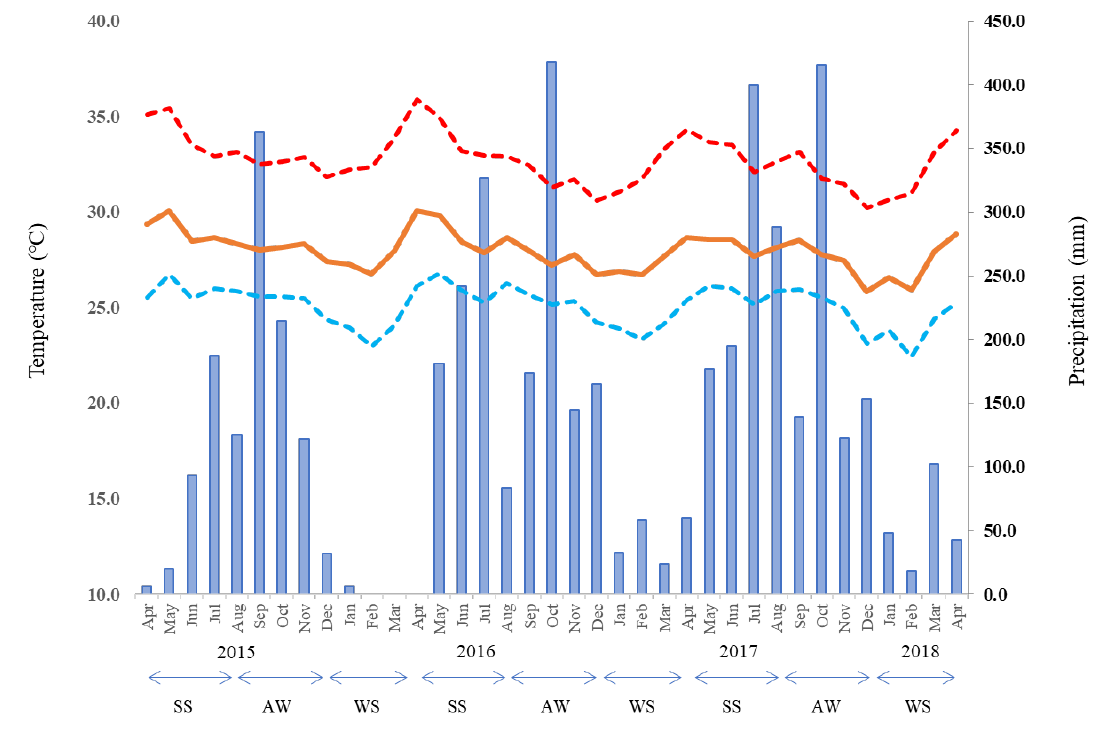
Figure 2. Monthly temperature and precipitation during the study period according to the represen- tative meteorological stations in An Giang Province. Table 1. Location, soil type, rainfall, and field management of six experimental sites.